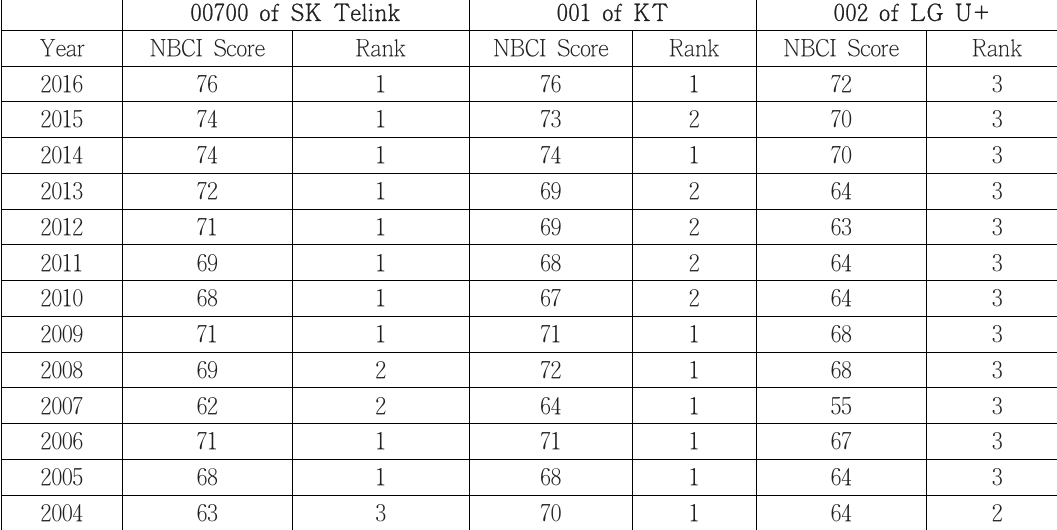
<Table 4> NBCI scores and ranks in the international phone call service market in Korea, KPC 2016